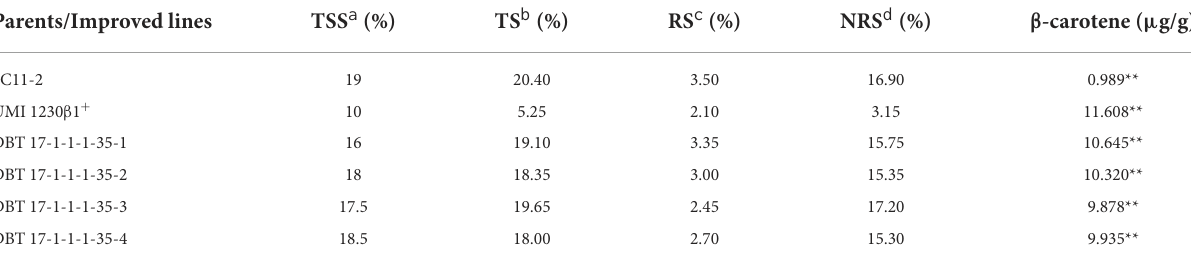
TABLE 4 Details of sugar and β -carotene contents in parents and BC 2 F 3 improved lines of SC11-2 × UMI 1230 β 1 + . Parents/Improved